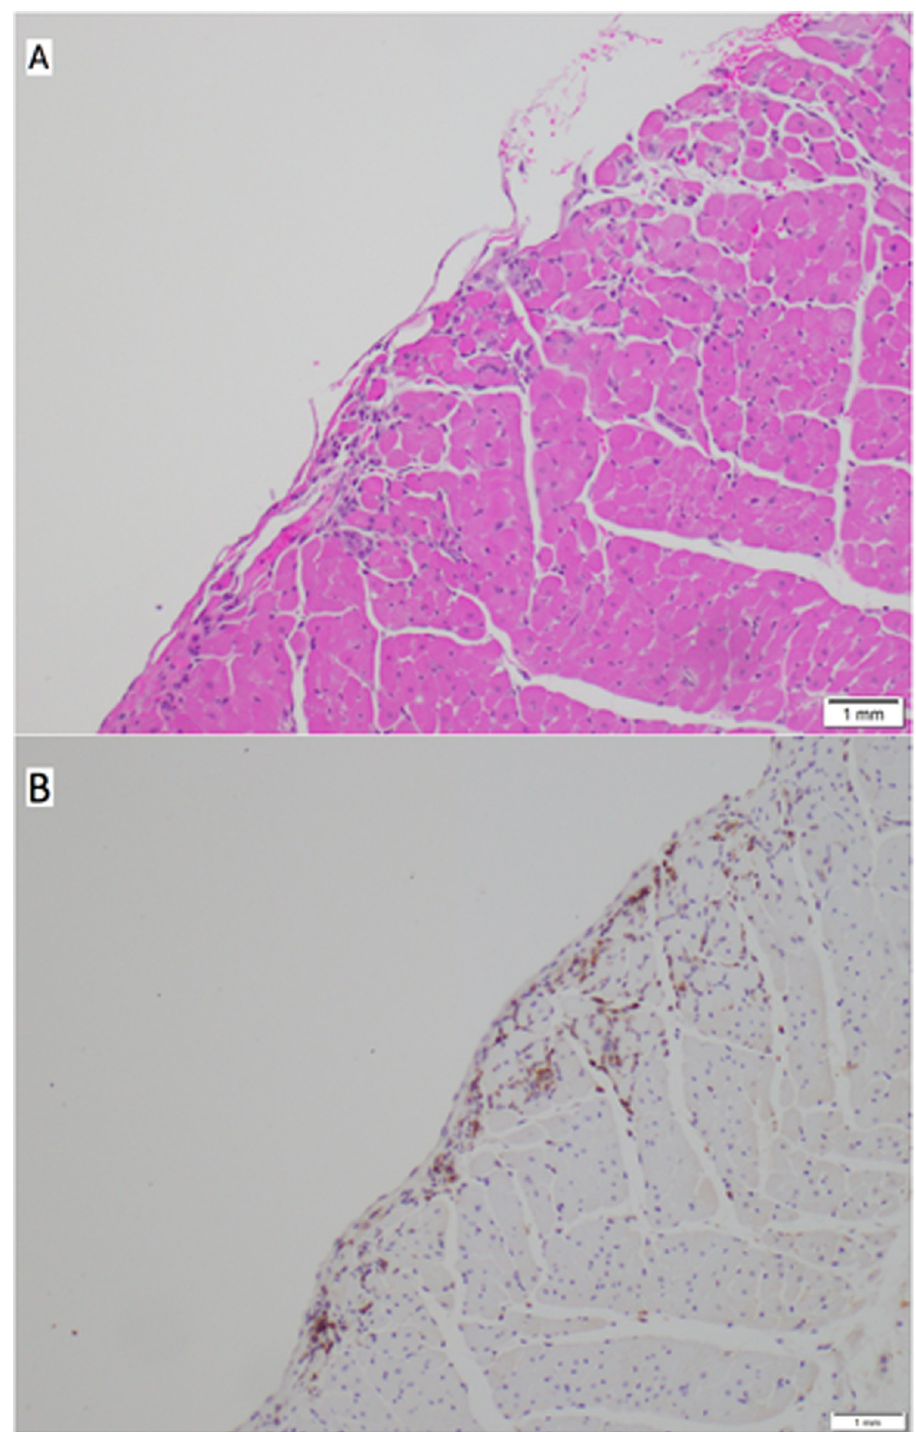
Fig 7. Photomicrographs of myocardial tissue on hematoxylin and eosin staining (A) and on myeloperoxidase (MPO) staining (B) demonstrating neutrophil infiltration.